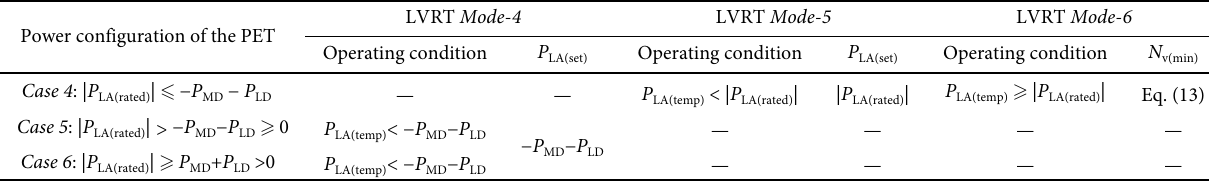
Table 2 Operating condition of each LVRT mode in the power-consumption state Power configuration of the